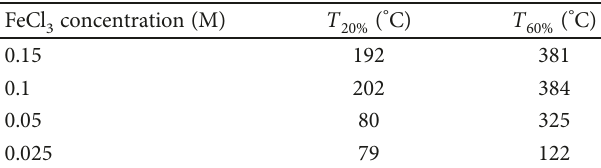
Table 5: TGA results for PPy samples with di ff erent concentrations of FeCl 3